Question: Summarize what this figure shows in one sentence.
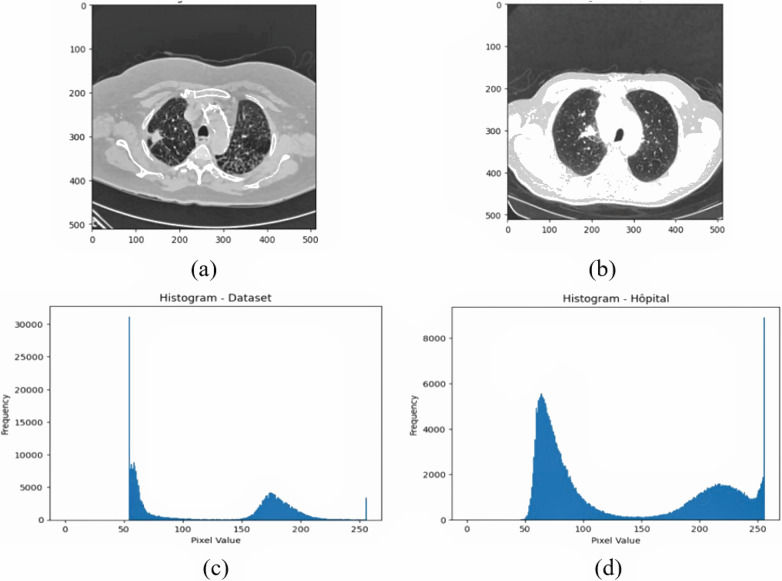
Answer: Differences between public dataset images and internal images (a) illustrates an image from SPIE-AAPM dataset, and (c) corresponds to its histogram. (b) illustrates an image from Cheikh Zaid Hospital, and (d) corresponds to its histogram. Images are raw, none CLAHE processing is applied.